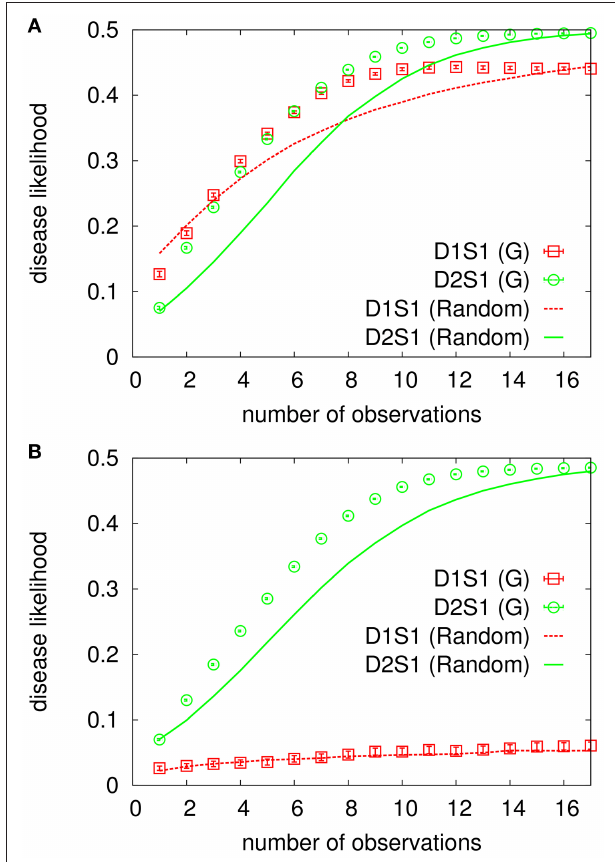
FIGURE 3 | Overlap of the inferred disease marginals with the true hypothesis for the exponential benchmark model. The data are for the cases in which only one (A) or two (B) diseases are present. The model parameters are obtained from the conditional marginals of the true model. There are N D 5 diseases, = N S 20 signs, and the algorithm starts with N O 3 observed signs for a = = randomly selected hypothesis D . An unobserved sign is chosen for observation by the greedy (G) or random strategy using the inferred probabilities, and the observed sign takes the true value given by S ∗ ( D ). The data are results of averaging over 1000 independent realizations of the true model and the observation